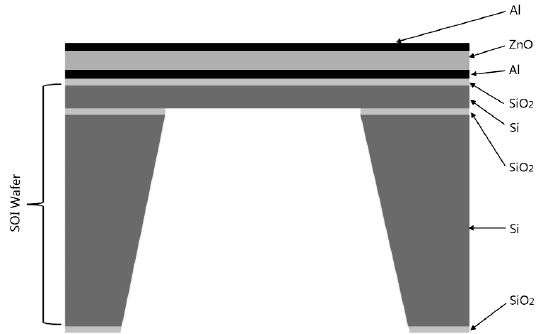
Figure 1. Structure of MEMS piezoelectric transducer.